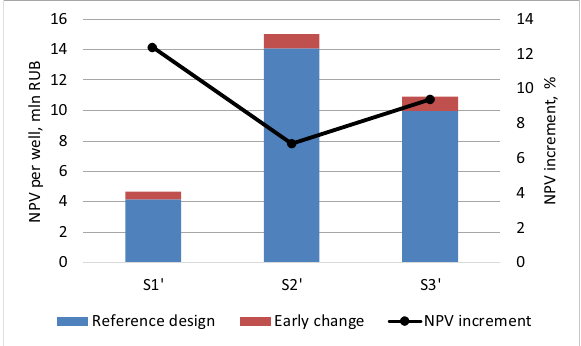
Fig. 13 Comparative performance of early corrected well pad designs and the reference designs for three scenarios S1 ′ , S2 ′ and S3’